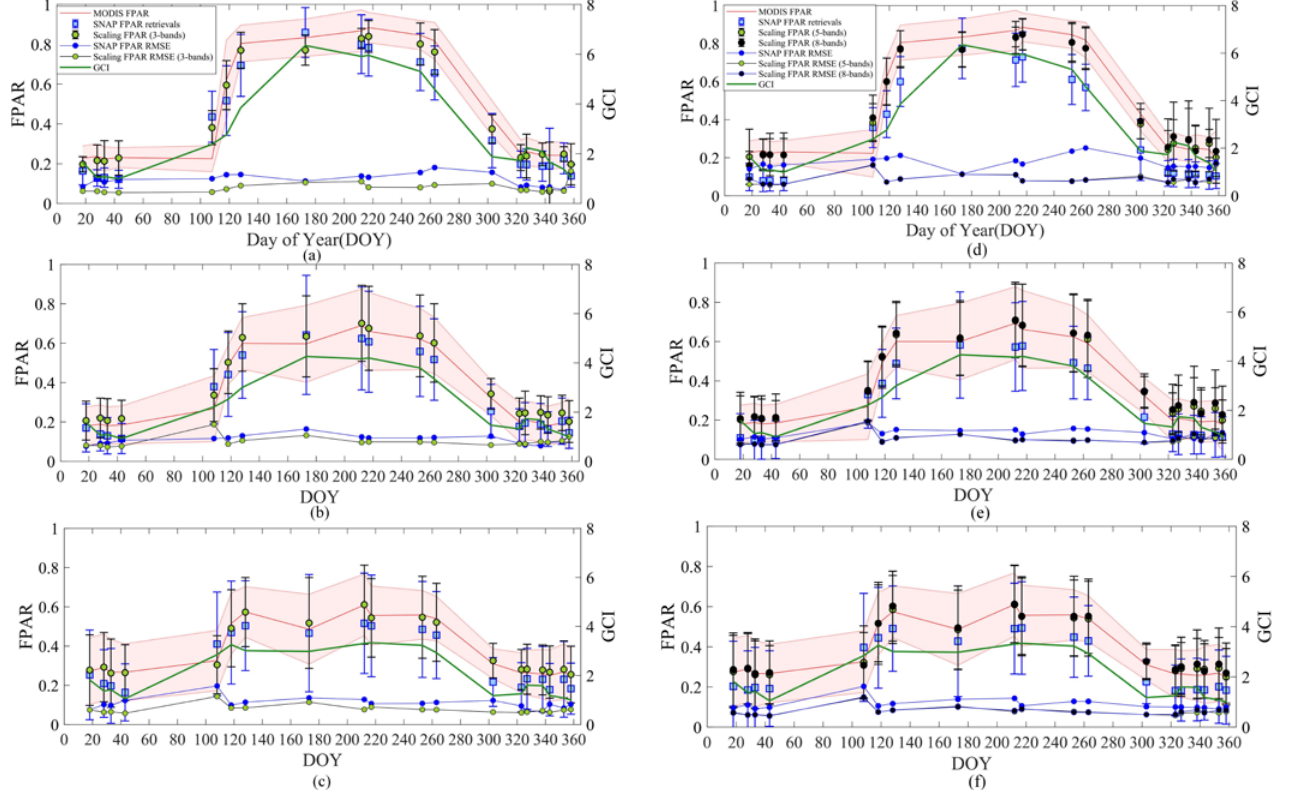
Figure 8. Spatiotemporal patterns of Sentinel FPAR retrievals using the SNAP and scaling-based methods in the study area in 2021 compared with the MODIS FPAR values and mean green chloro- phyll vegetation index as a function of DOY for ( a , d ) woodland, ( b , e ) grassland, and ( c , f ) cropland.